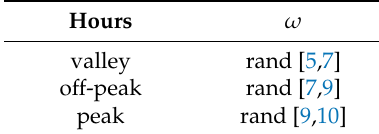
Figure 4. IEEE 14 nodes distribution network system. Table 1. The user purchase intention parameter ω .